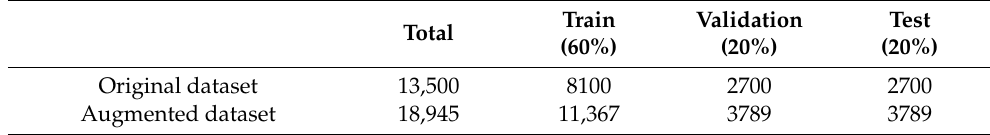
Table 3. Description of the amount of data in the raw dataset and augmented